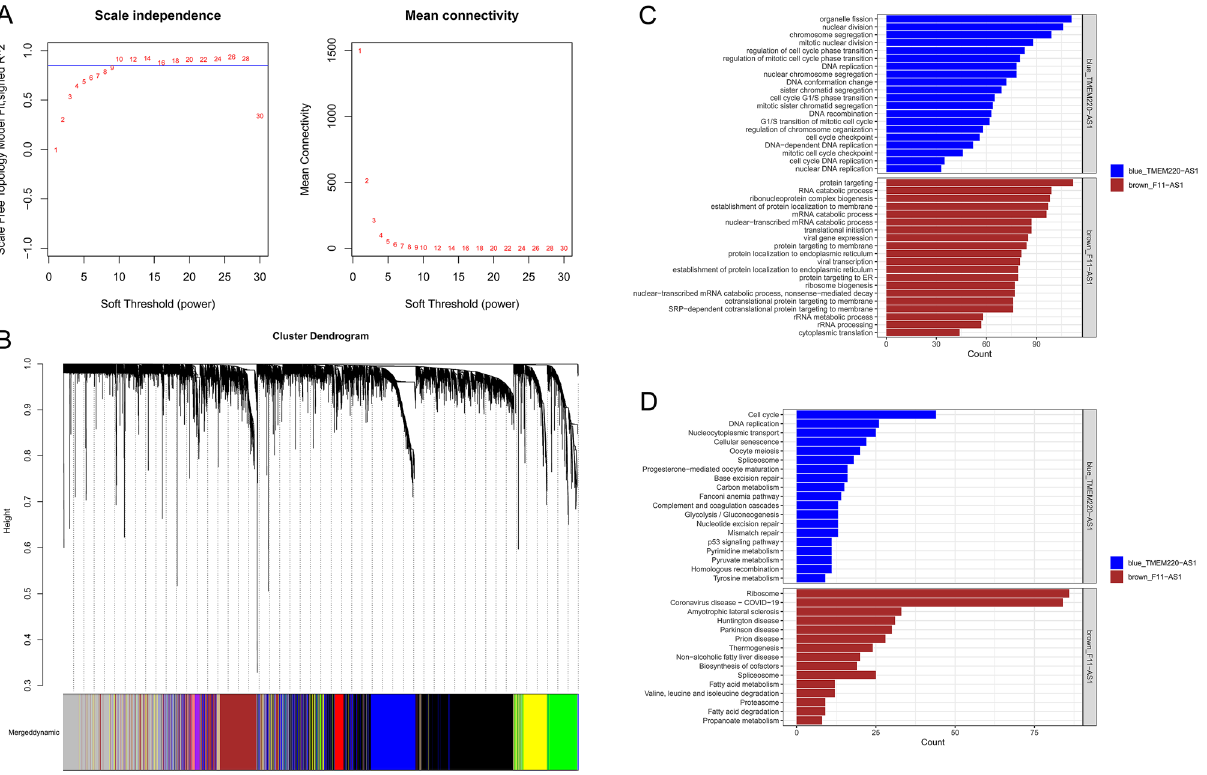
Figure 9. Co-expression modules of prognostic-related lncRNAs and differentially expressed (DE) mRNAs. (A ) Determination of soft threshold for adjacency matrix. The horizontal axis represents the soft threshold power and the vertical axis represents the square of the correlation coefficient of between log 2 k and log 2 p (k). The blue line indicates where the correlation coefficient is 0.85, and the corresponding soft threshold power is 10. ( B ) Gene dendrogram derived from hierarchical clustering. Different modules are indicated by colors underneath the dendrogram. ( C ) Gene Ontology (GO)-biological process (BP) and ( D ) Kyoto Encyclopedia of Genes and Genomes (KEGG) pathways involved in the blue and brown